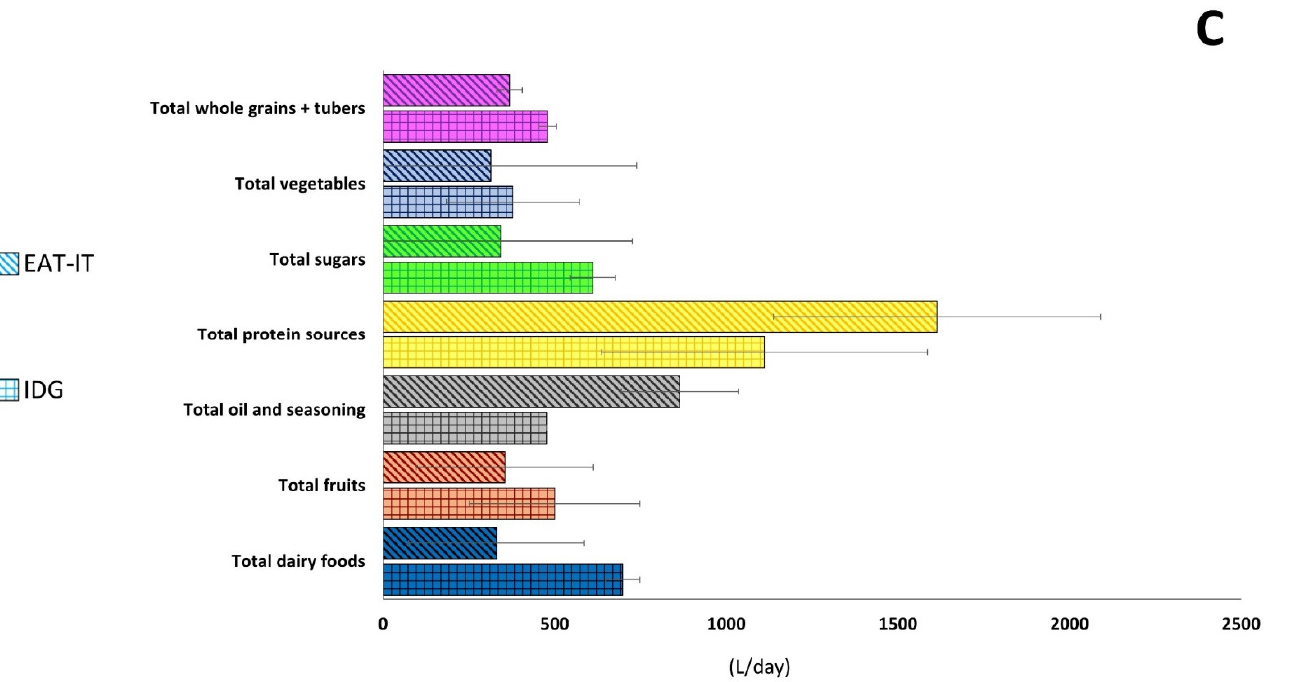
Figure 3. Total ( A ) water footprint associated with EAT-IT and IDG dietary patterns and relative ( B ) and percentage contribution ( C ) of the different food categories. Legend: EAT-IT: EAT-Lancet Commission reference diet (adapted to the Italian food habits); IDG: Italian Dietary Guidelines; WF: water footprint.